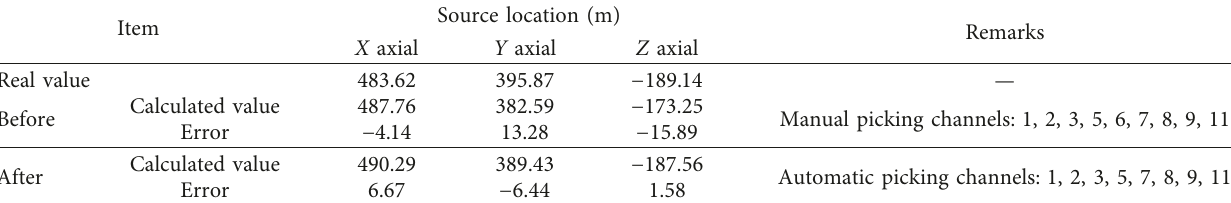
Table 7: Comparison of results before and after